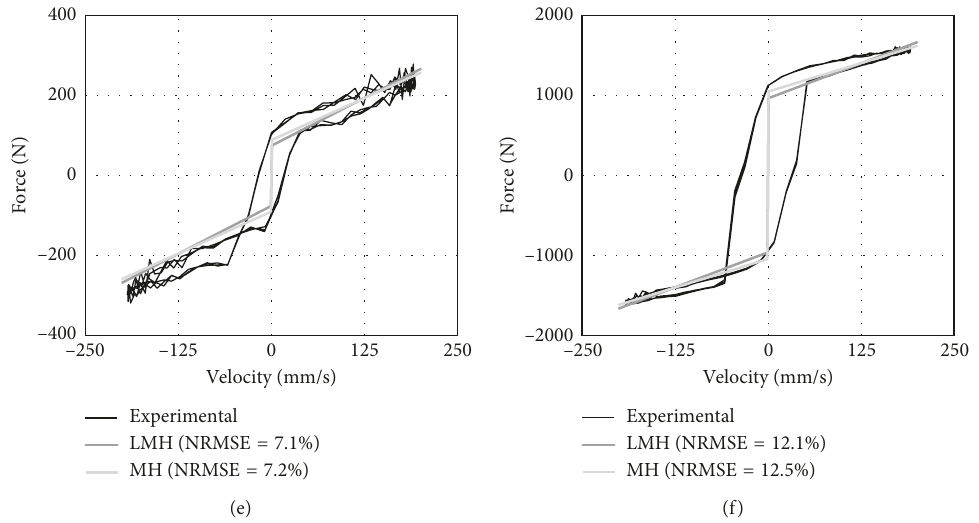
Figure 7: Bingham model (fitted with LMH and MH tests) predictions for six different tests: (a) low velocity without intensity; (b) low velocity with I 1 A; (c) medium velocity without intensity; (d) medium velocity with I (cid:31) velocity with I (cid:31)